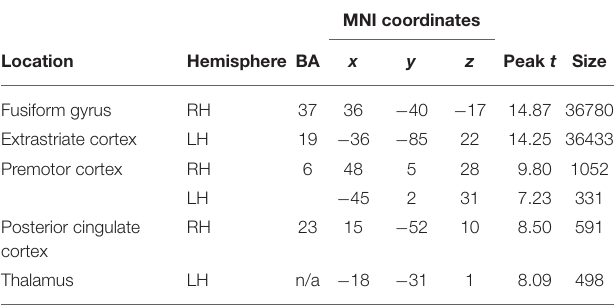
TABLE 3 | Cluster location and peaks across age groups (RF + RS > RM + RV). MNI